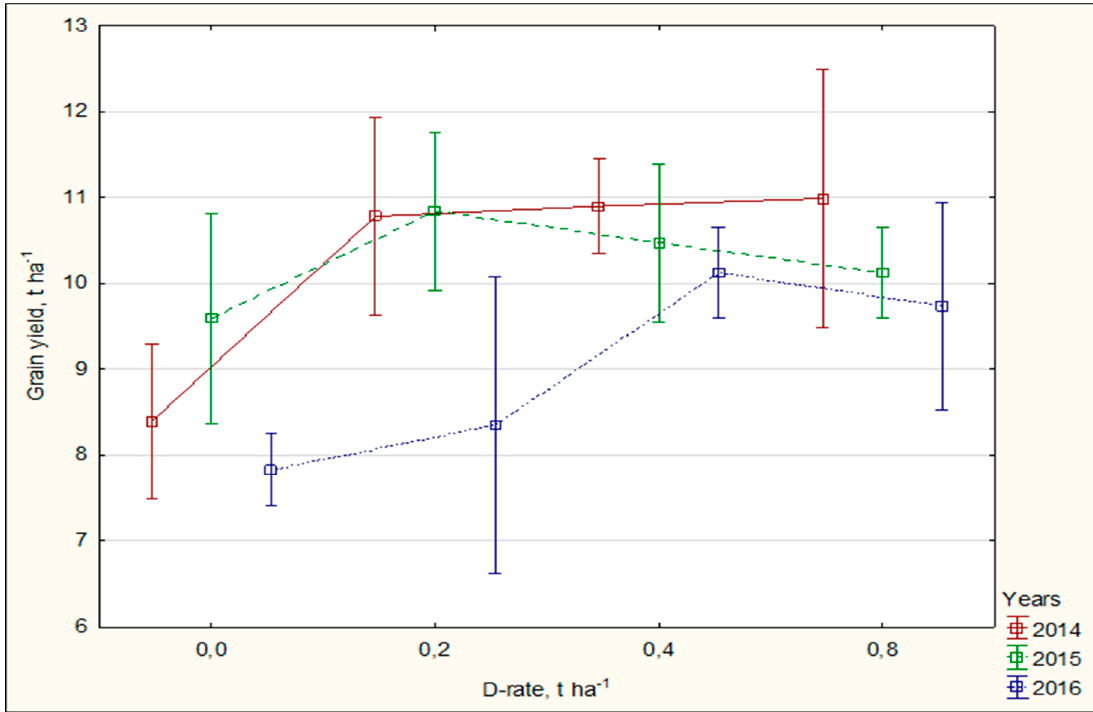
Figure 2. Grain yield of maize response to the increasing rates of digestate in consecutive years. The bars indicate a double standard error of the mean ( n = 8). Table 4. Effect of digestate application method and rate on soil pH, content of inorganic nitrogen, and plant-available macronutrients.